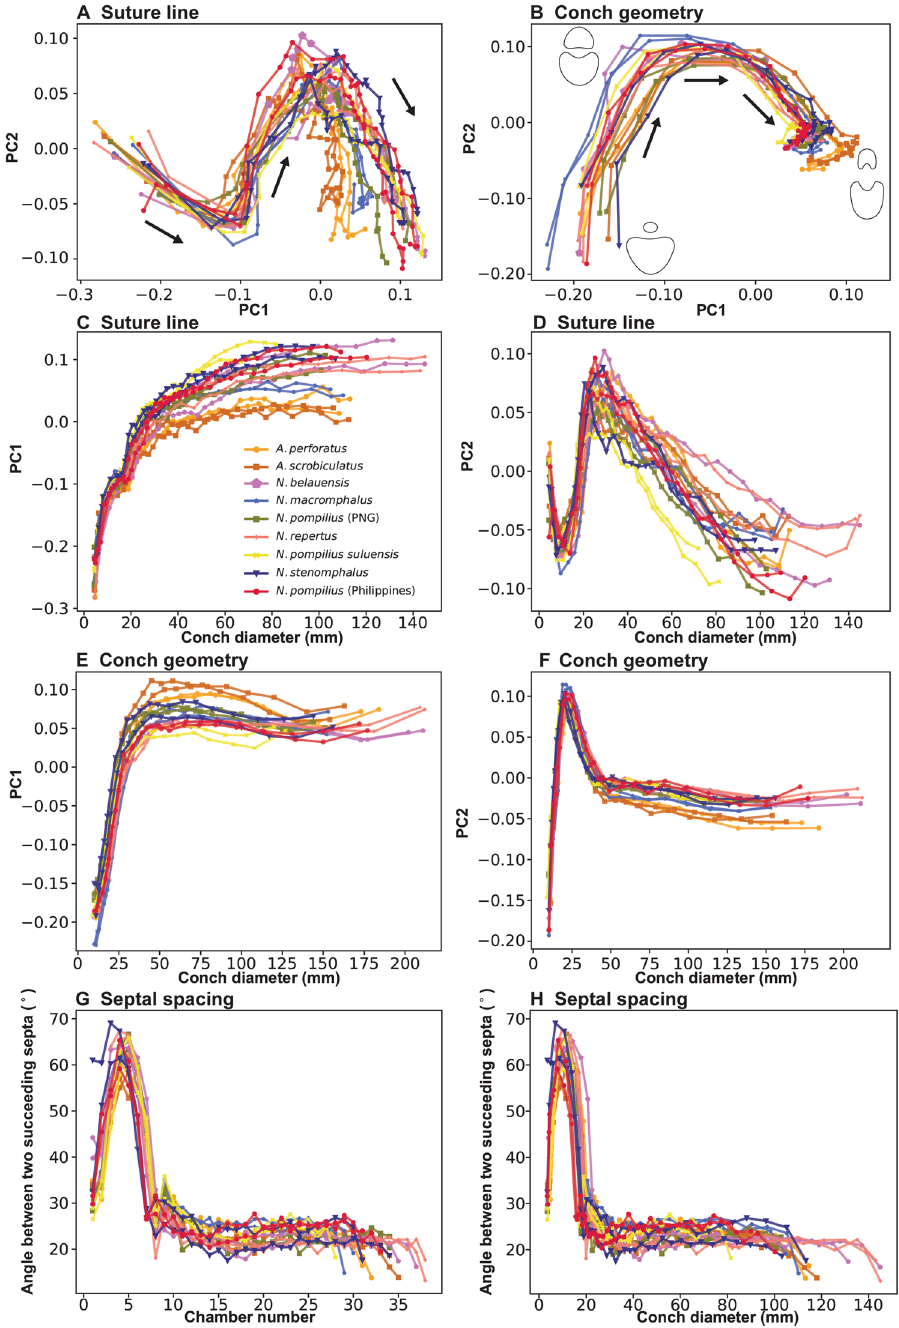
Figure 2. Results of morphological analysis. Points from the same individual are connected with a line. Arrows indicate the direction of growth. ( A ) PCA plot graph for sutural morphology. ( B ) PCA plot graph for conch geometry (cross-sectional morphology). ( C ) PC1 plotted against conch diameter for sutural morphology. ( D ) PC2 plotted against conch diameter for sutural morphology. ( E ) PC1 plotted against conch diameter for conch geometry. ( F ) PC2 plotted against conch diameter for conch geometry. ( G ) Septal spacing (septal rotational angle) plotted against chamber number. ( H ) Septal spacing (septal rotational angle) plotted against conch diameter